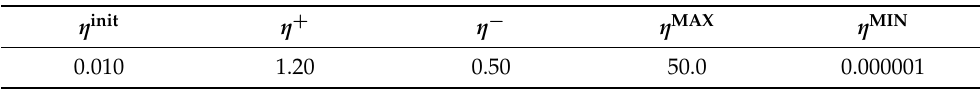
Table 4. Parameters of the steepest descent method with the Rprop